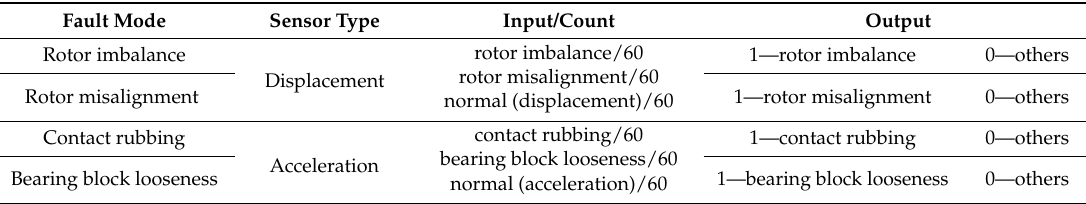
Table 1. Input and output of the CNNs.